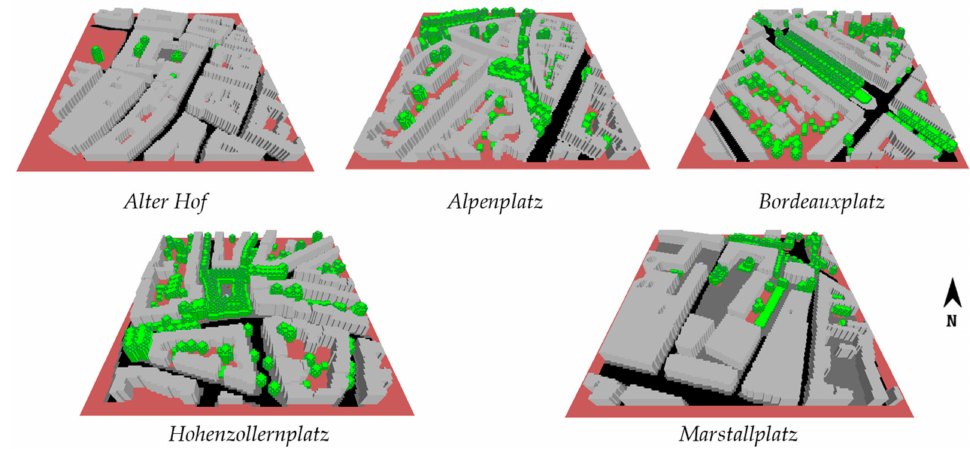
Figure 4. 3D graphic representation of the studied square models. Table 2. ENVI-met model setup and meteorological input